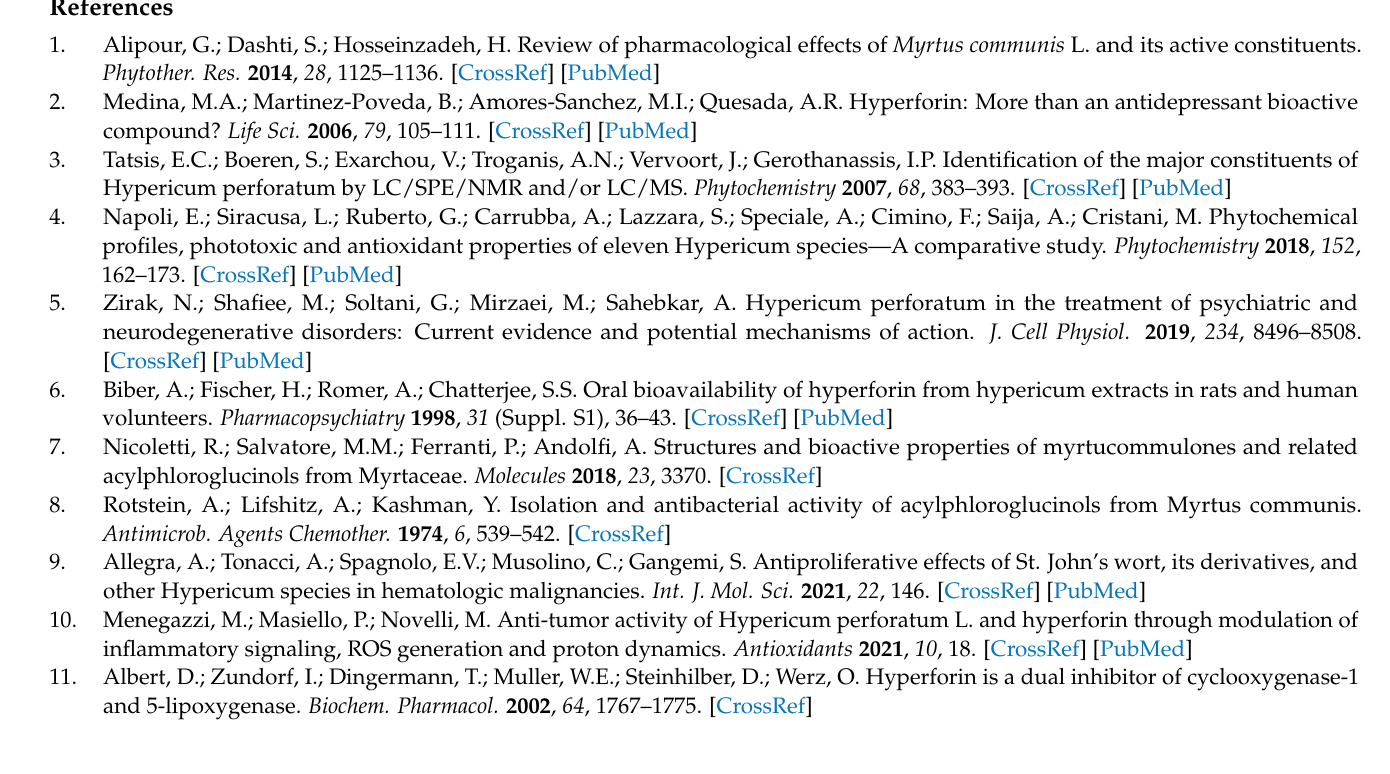
Figure A2. Active β -catenin is down-regulated in response to treatment with HF and MCs in HCT116 cells. Cell lysates were analyzed by SDS-PAGE and Western blotting, with the indicated antibodies. Interestingly, protein levels of the Wnt target genes c-myc and cyclin D1 revealed a similar behavior. The image shows a representative Western blot of two independent blots.